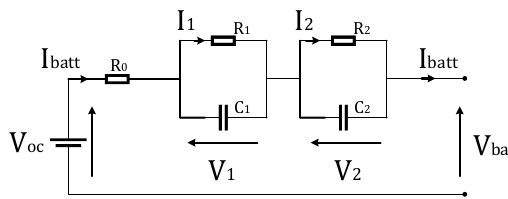
Figure 2. Electrical model for the NMC pouch